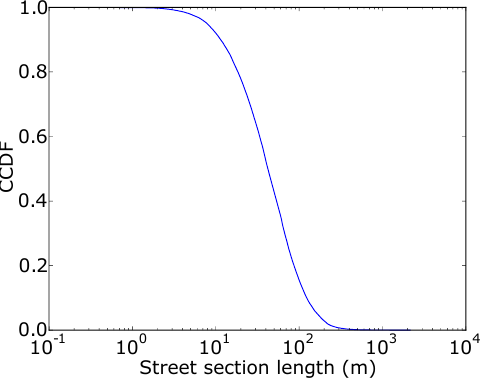
Figure 3. Distribution of estimated street section lengths captured with Snap to